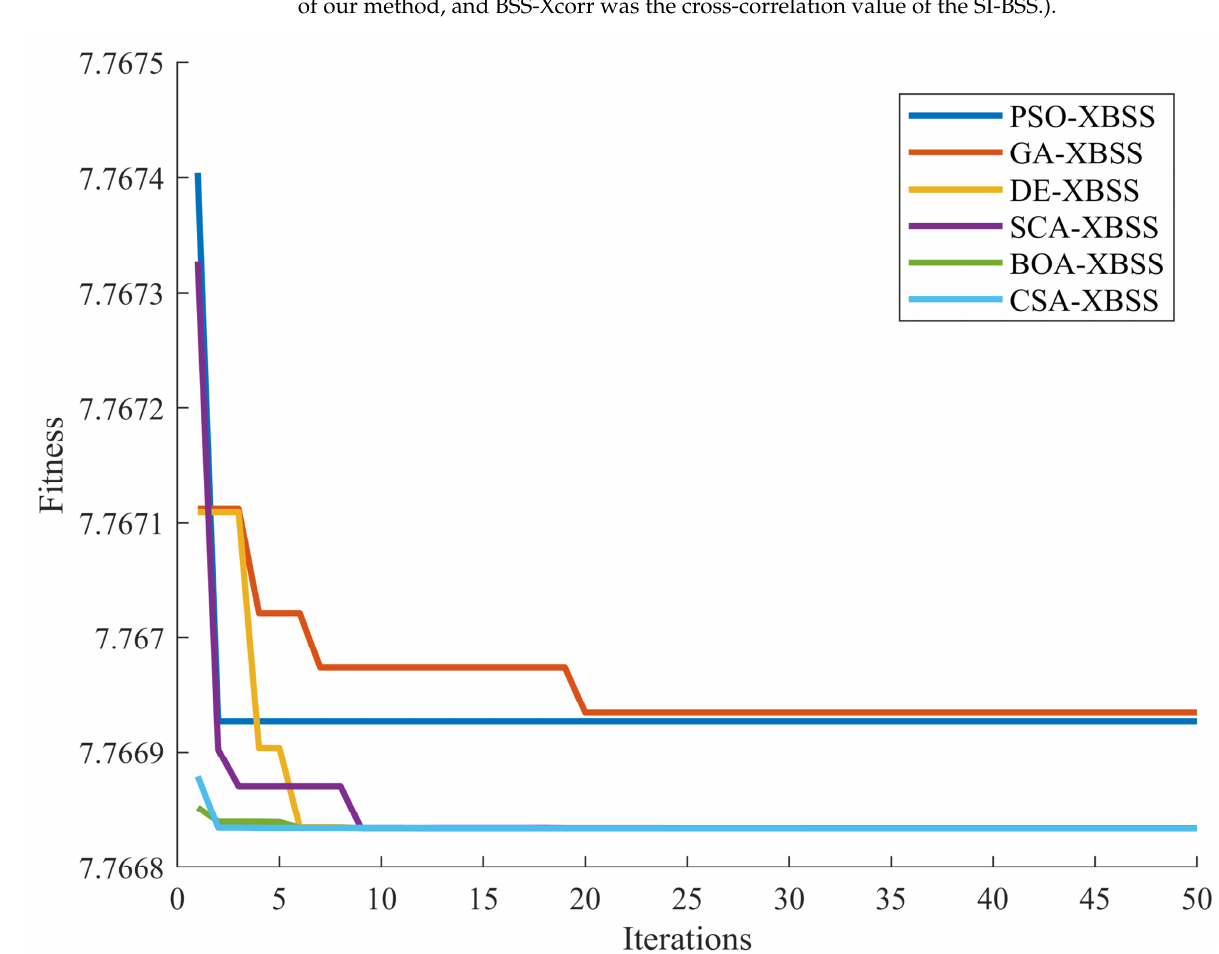
Table 3. Comparison of the evaluation mean values of SI-SDR, PESQ, and STOI. (   represents the